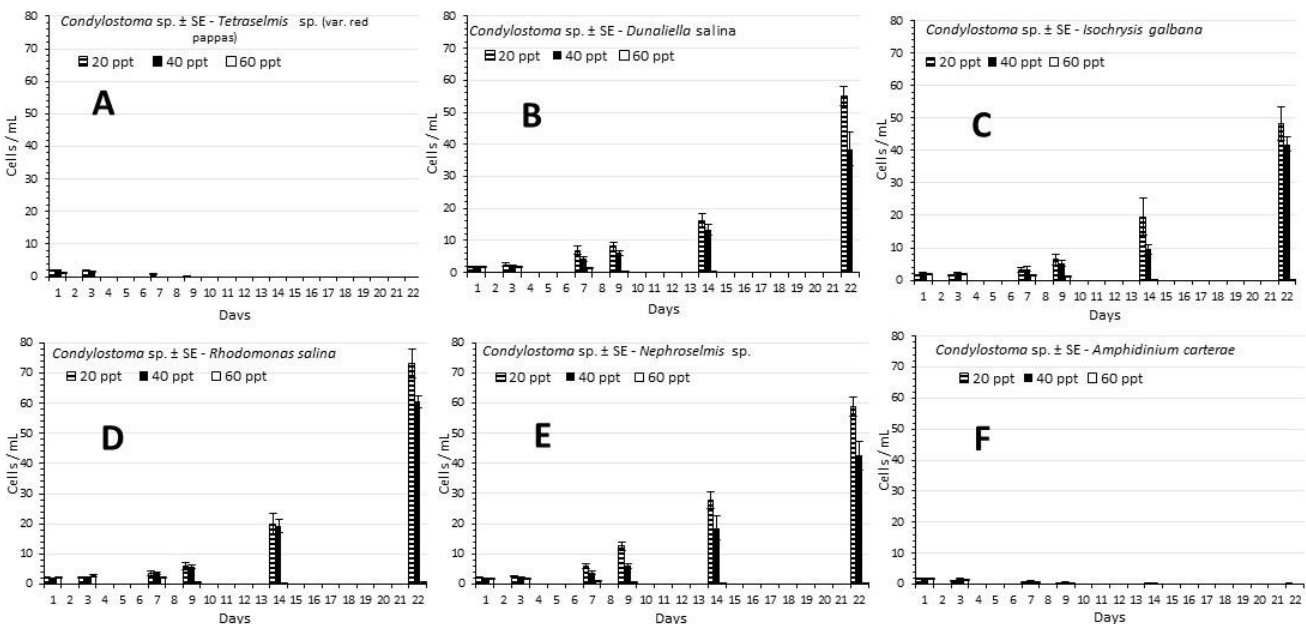
Figure 3. The development of the density ± SE of Condylostoma sp. (cells/mL) in the different treatments of microalgae used at the salinities of 20, 40 and 60 ppt. ( A ) Tetraselmis sp. (var. red pappas), ( B ) Dunaliella salina , ( C ) Isochrysis galbana , ( D ) Rhodomonas salina , ( E ) Nephroselmis sp., ( F ) Amphidinium carterae .